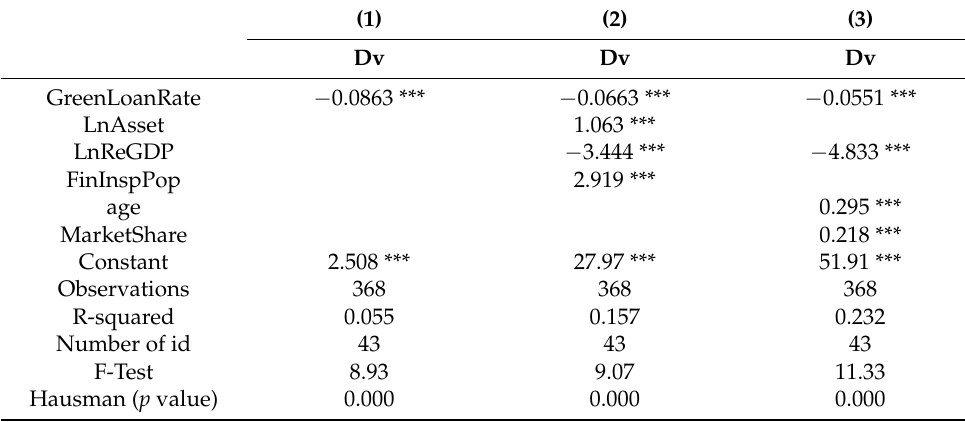
Table 6. The regression results for the green credit ratio on non-radial distances.